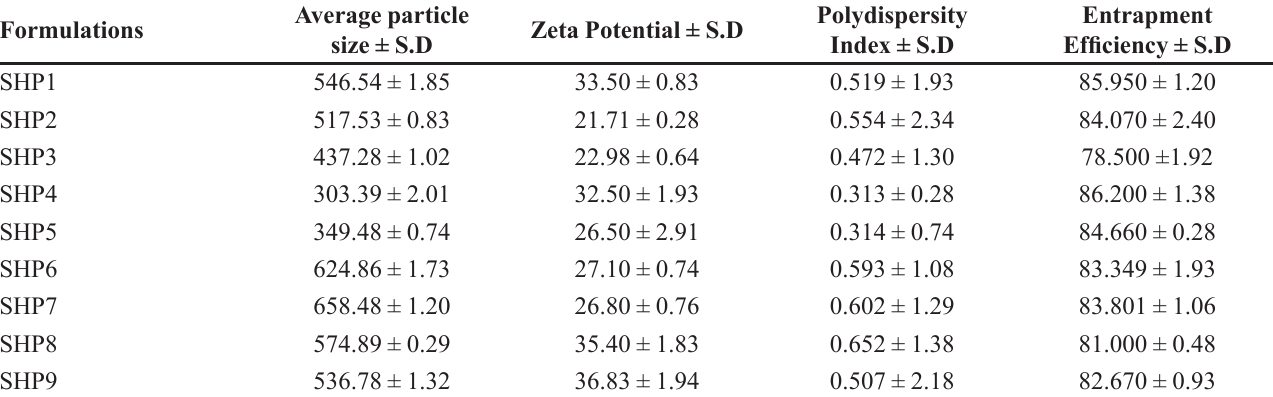
TABLE III - Data for evaluation parameters of selegiline hydrochloride loaded nanoparticles Formulations